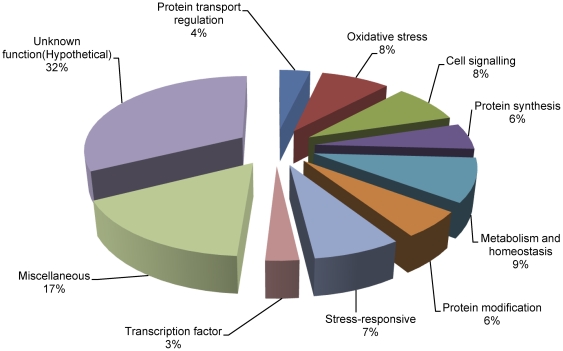
Functional cataloging of menadione-responsive genes.Genes were assigned a putative function based on their homology and classified on the basis of their functions.